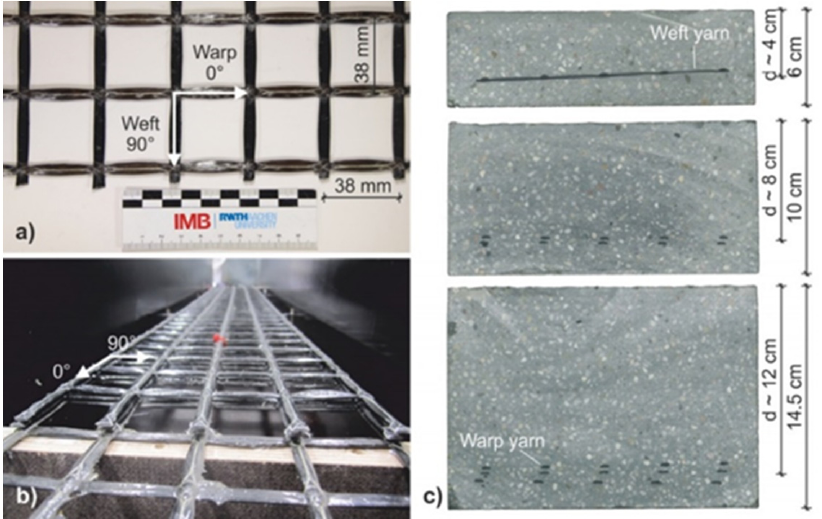
Figure 1. Biaxial textile carbon grid ( a , b ), as well as the cross-section of the concrete specimens ( c ) [6].